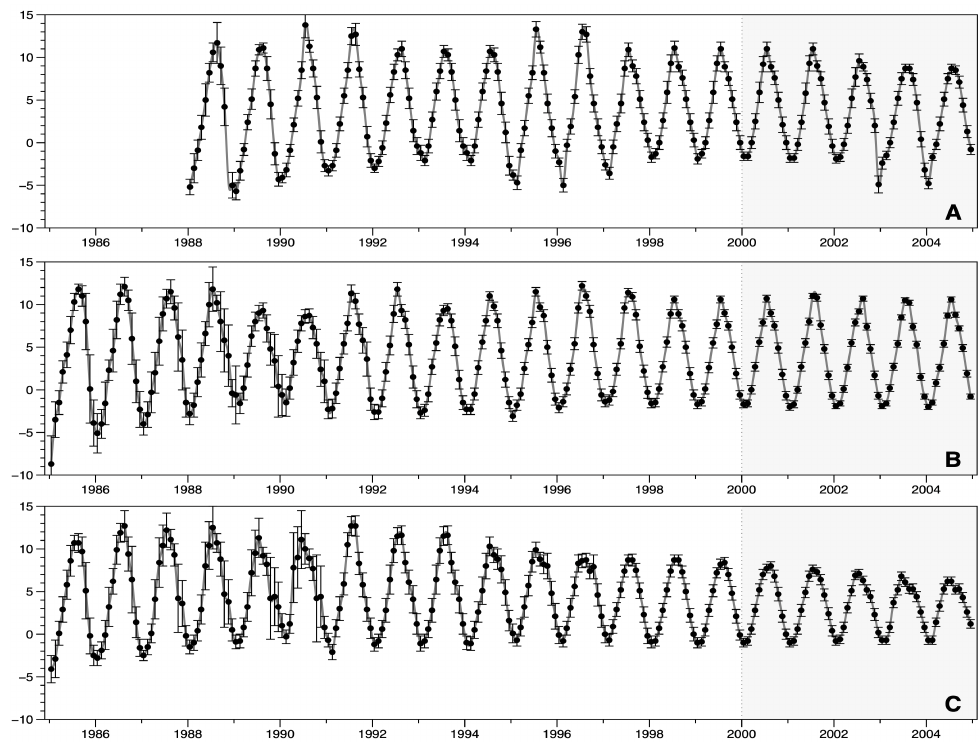
Figure 15. Time series extracted at the sites A (top), B (middle) and C (botom) marked in Figure 14. Time is in years and field values in ◦ C. The shadowed area marks the extrapolated values. Time series A starts in 1988, as there were no recording stations nearby